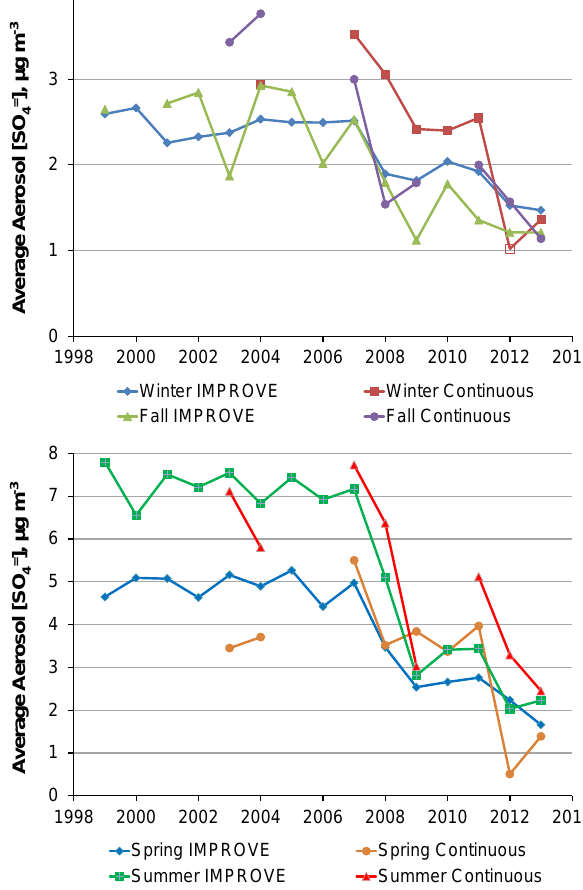
Figure 9. Trends in seasonal PM 2 . 5 sulfate mass at Look